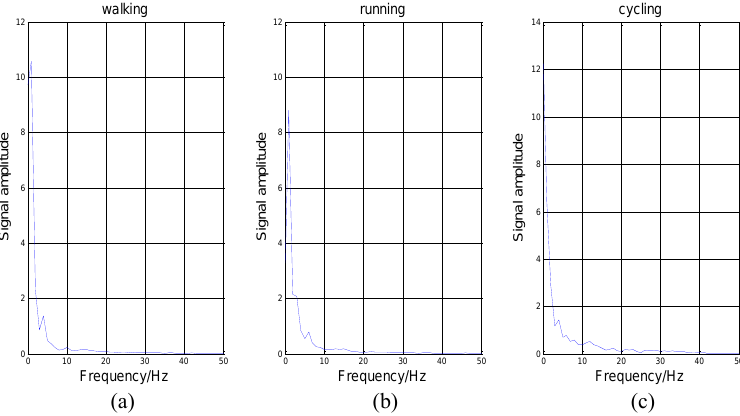
Figure 7. The marginal spectrum (MS) of three different activities. In some time periods, the variation tendency and signal amplitude of MS for different activities are similar. ( a ) The MS of walking data; ( b ) The MS of running data; ( c ) The MS of cycling data. All data come from the x-axis of the accelerometer on the